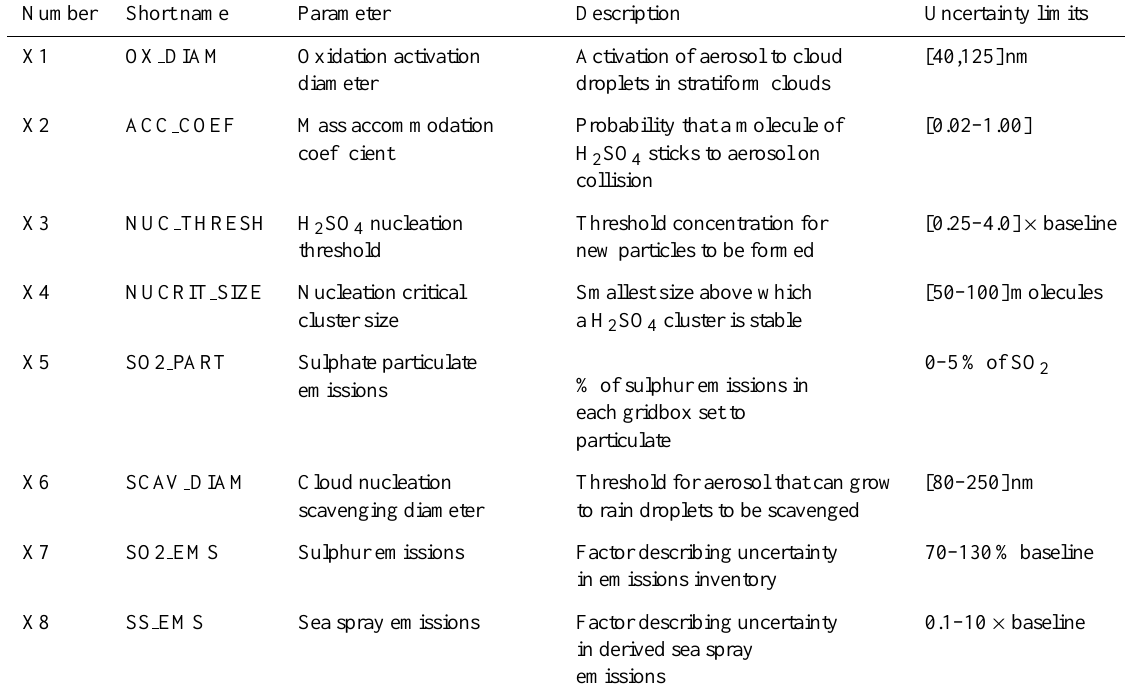
Table 1. The model parameters and emissions, and their uncertainty ranges, used in this study.